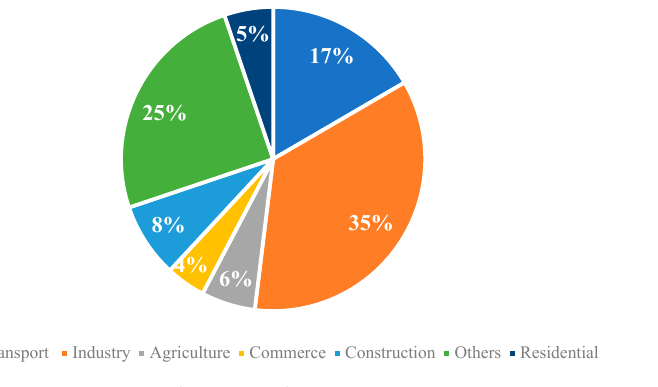
Figure 15. Emission share in each